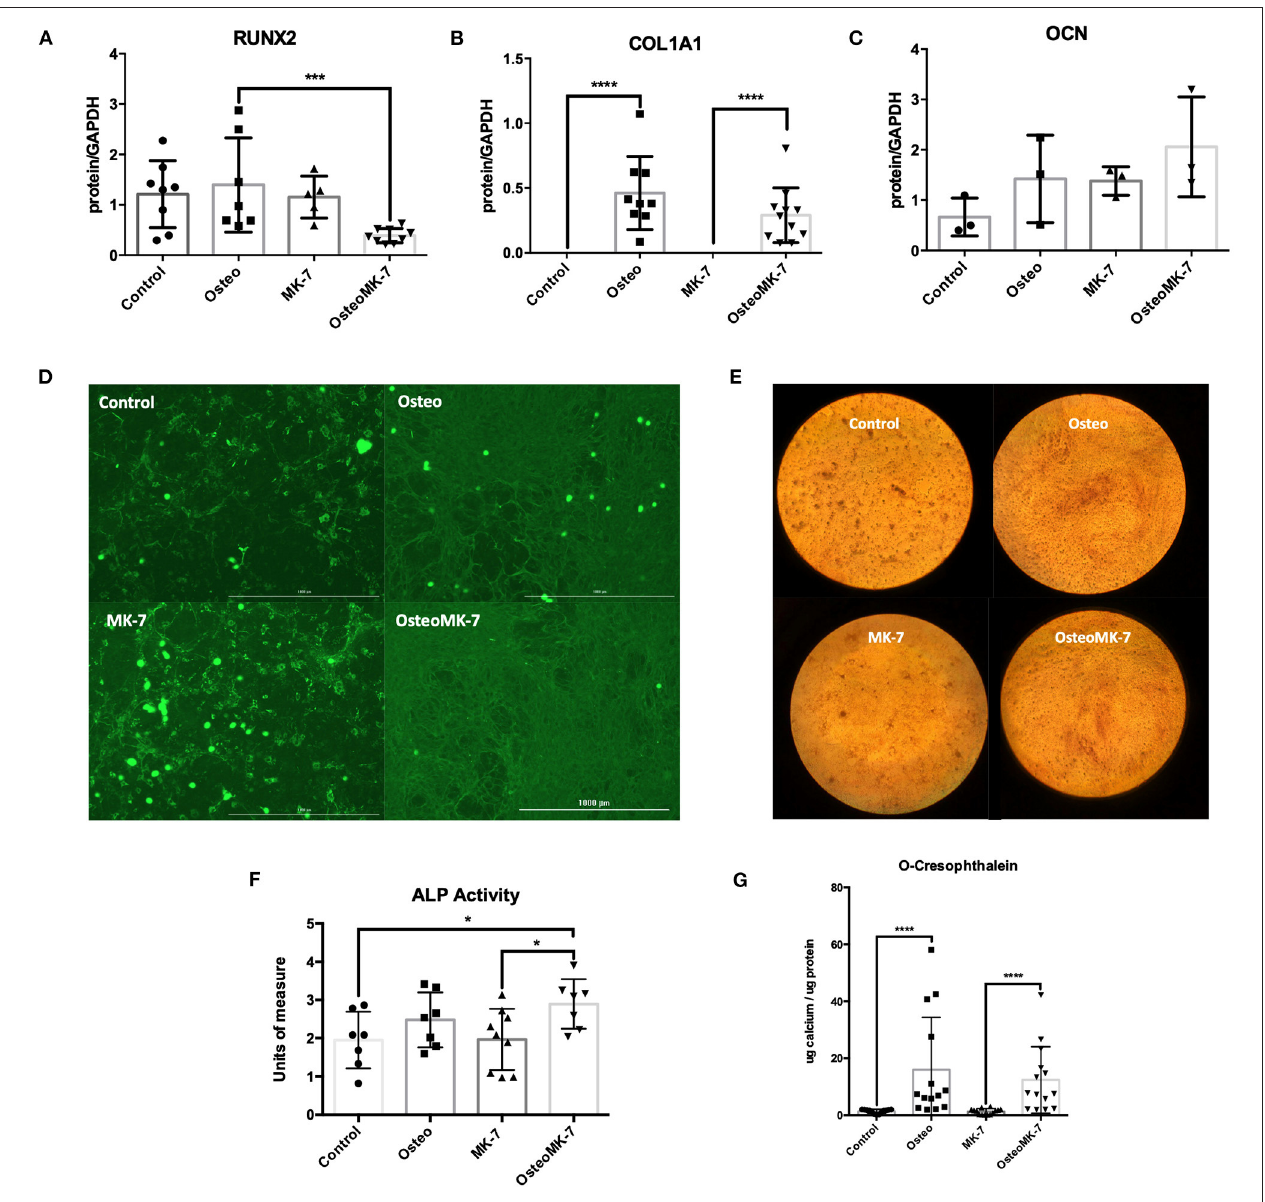
FIGURE 4 | Protein expression at late osteoblast differentiation. Western blotting following 21 days differentiation for RUNX2 shows that following 21 days osteogenic treatment with MK-7 that RUNX2 is significantly downregulated compared to other samples (A) ( p = 0.0003). Collagen 1A1 is upregulated in osteogenic conditions without any difference compared to MK-7 supplementation and OCN has no difference in expression (B,C) ( p ≤ 0.0001). Immunocytochemistry staining for COL1A1 shows that a completely different mode of collagen deposition has occurred following osteogenic treatment, although there are nodules present in the control and control MK-7 treated cells that resemble COL1A1 osteogenic deposition (D) . Representative photos of the cells stained with Alizarin Red at day 21 (magnification 10x) (E) . At day 21 control, osteogenic and MK-7 treated groups show no difference in ALP levels. Only osteogenic media supplemented with MK-7 was able to induce significant upregulation in ALP activity (F) ( p = 0.0418). Quantification of calcium deposition by o-cresophthalein assay at day 21 (G) . * p < 0.05, *** p < 0.001, **** p <